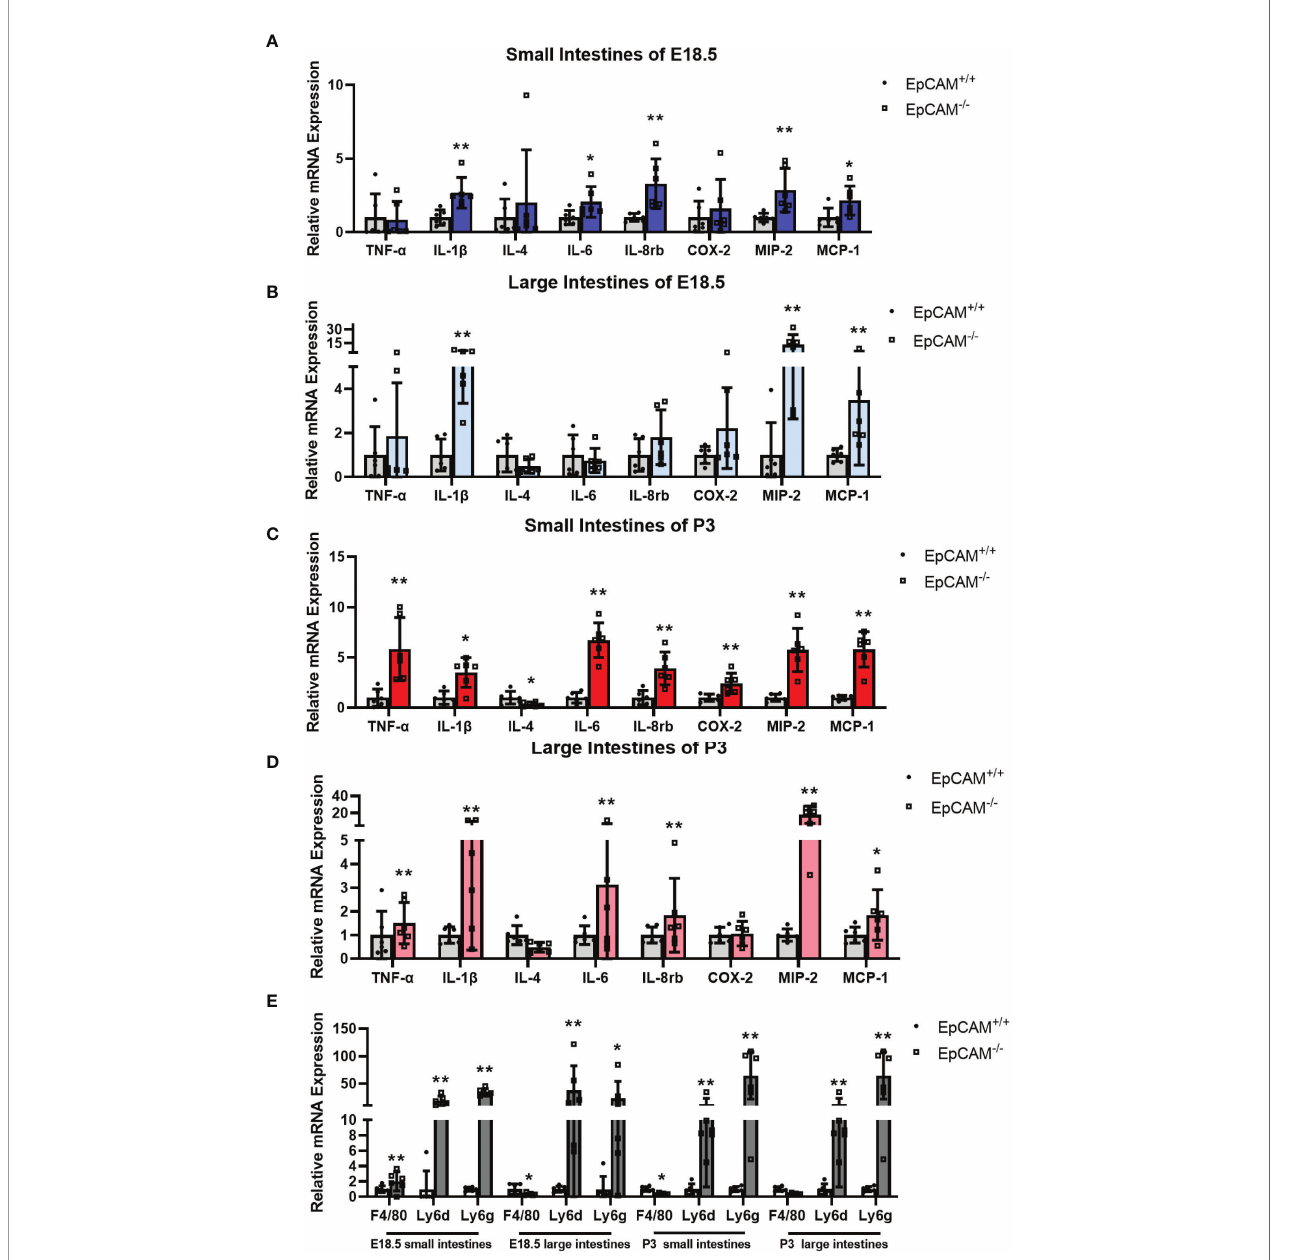
FIGURE 2 | EpCAM de fi ciency induced the upregulation of genes related to in fl ammatory factors and the in fi ltration of in fl ammatory cells in the intestines of mice. (A, B) Graphs showed the relative mRNA expression levels of TNF- a , IL-1 b , IL-4, IL-6, IL-8rb, COX-2, MIP-2 and MCP-1 in the (A) small and (B) large intestines from WT and EpCAM -/- embryos at E18.5 stage (n=6). (C, D) Graphs showed the relative mRNA expression levels of TNF- a , IL-1 b , IL-4, IL-6, IL-8rb, COX-2, MIP-2 and MCP-1 in the (C) small and (D) large intestines from WT and EpCAM -/- pups at P3 stage (n=6). (E) qPCR results of F4/80, Ly6d and Ly6g from the small and large intestines of WT and EpCAM -/- mice at E18.5 and P3 stages, respectively (n=6). * p < 0.05, ** p < 0.01, as determined by Mann – Whitney U test. All error bars represent